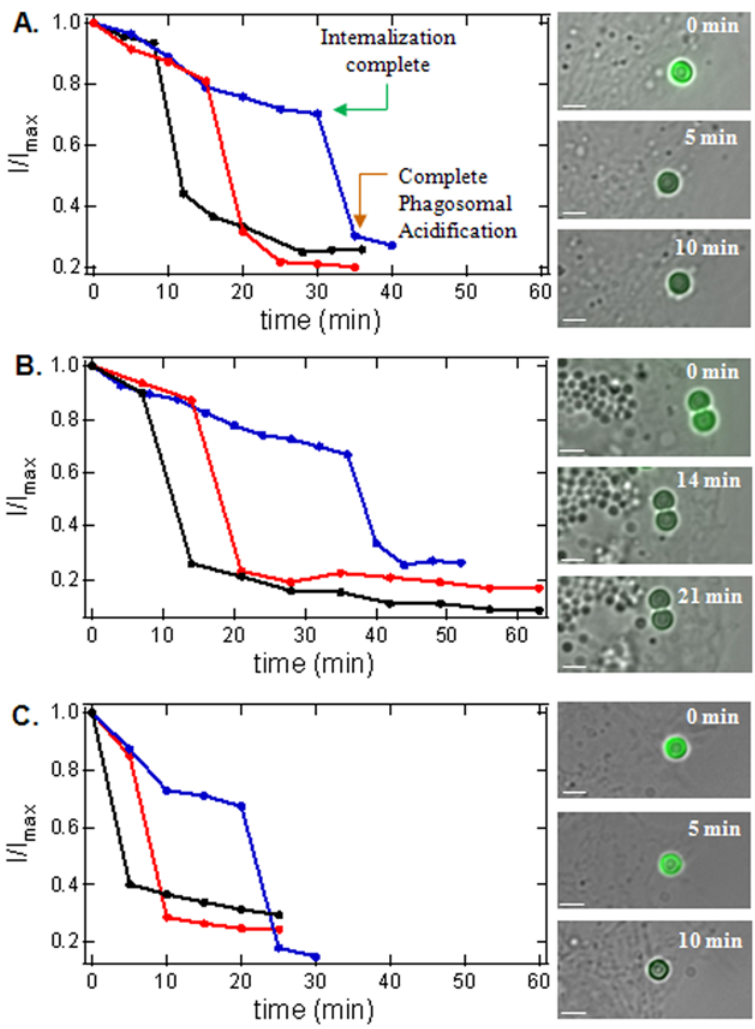
Figure 4. Application of FITC-labeled beads for real-time reporting of phagosomal acidification by tracking the fluorescence intensity of a single bead with time, from the time of initial binding to the cell through the completion of acidification, as demonstrated for FITC/InlA- in MDCK epithelial or Caco-2 epithelial cells or FITC/fibronectin-beads in NIH 3T3 fibroblast cells. A.) Real-time measurement of phagosomal acidification by tracking the fluorescence intensity of single FITC/InlA beads with time in MDCK cells. B.Real- time measurement of phagosomal acidification by tracking the fluorescence intensity of single FITC/InlA-beads in Caco-2 cells. C. Real-time measurement of phagosomal acidification by tracking the fluorescence intensity of single FITC/fibronectin-beads in 3T3 fibroblast cells. Images are representative of bead/cells before and after phagosomal acidification. Scale bar 2 m m (Three different lines, blue, red, and black, represent separate experiments with different